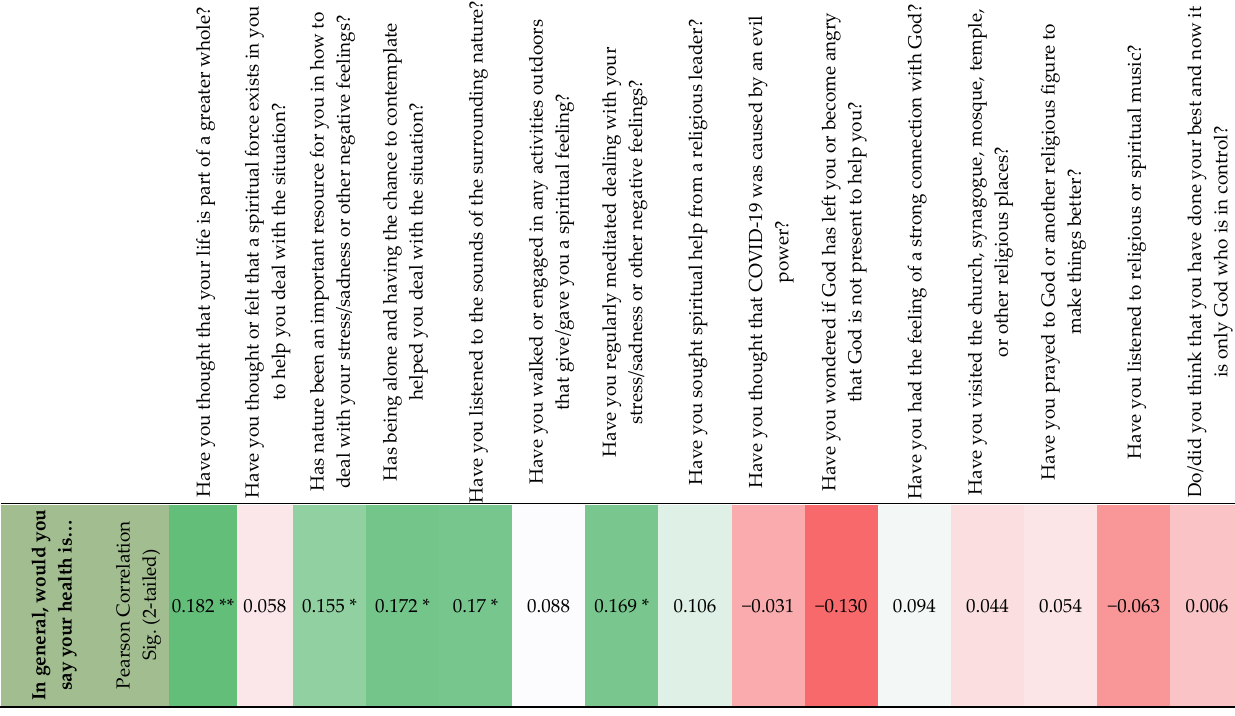
Figure 4. Correlation between self-rated health and frequency of different coping methods. Note. ** Correlation is significant at the 0.01 level (2-tailed); * Correlation is significant at the 0.05 level (2-tailed); Dark green shows the strongest correlation, and dark red the weakest correlation.